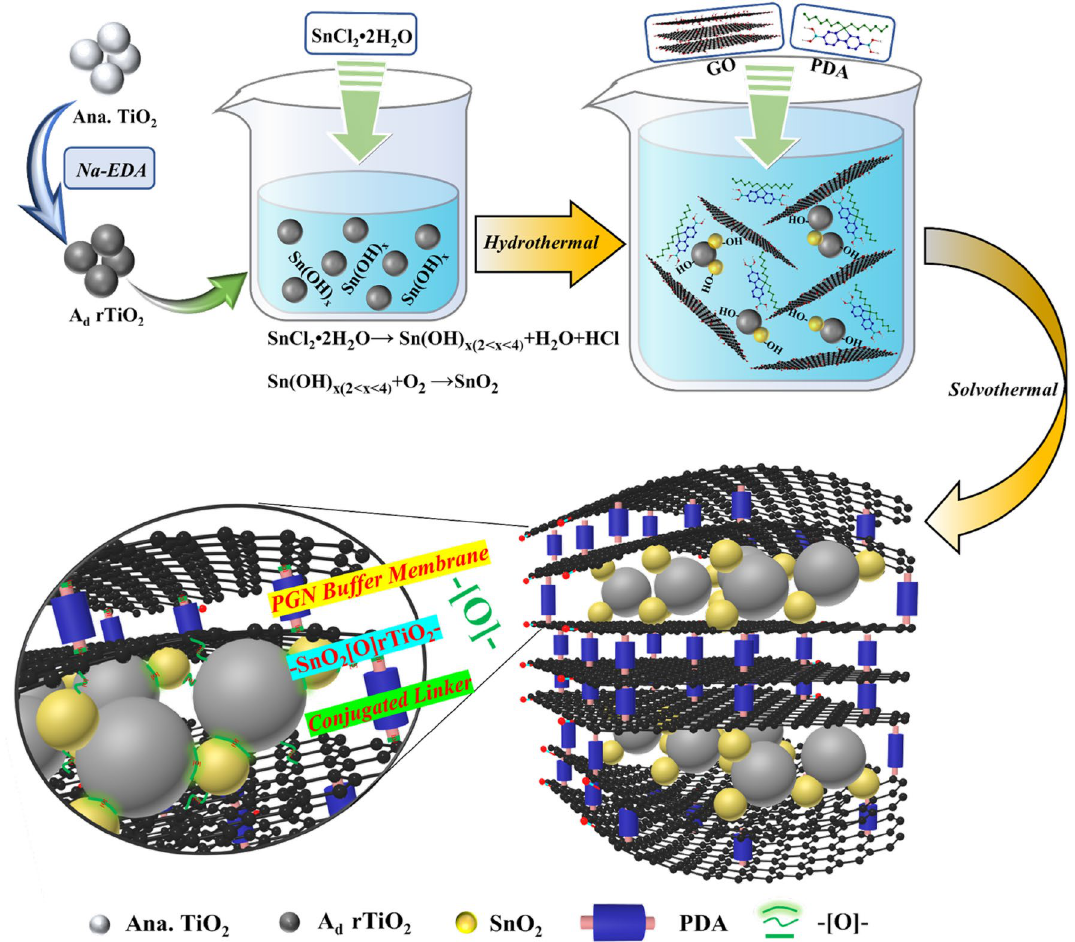
Figure 1. Synthesis route illustrations of SnO 2 [O]rTiO 2 -PGN